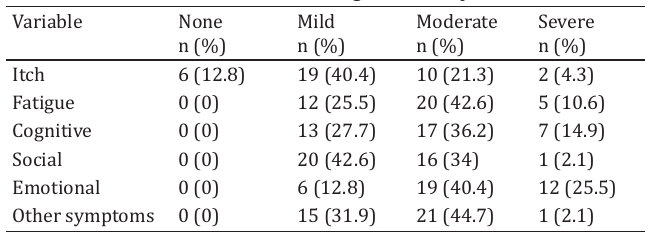
Classification of PBC-40 questionnaire domains according to severity.